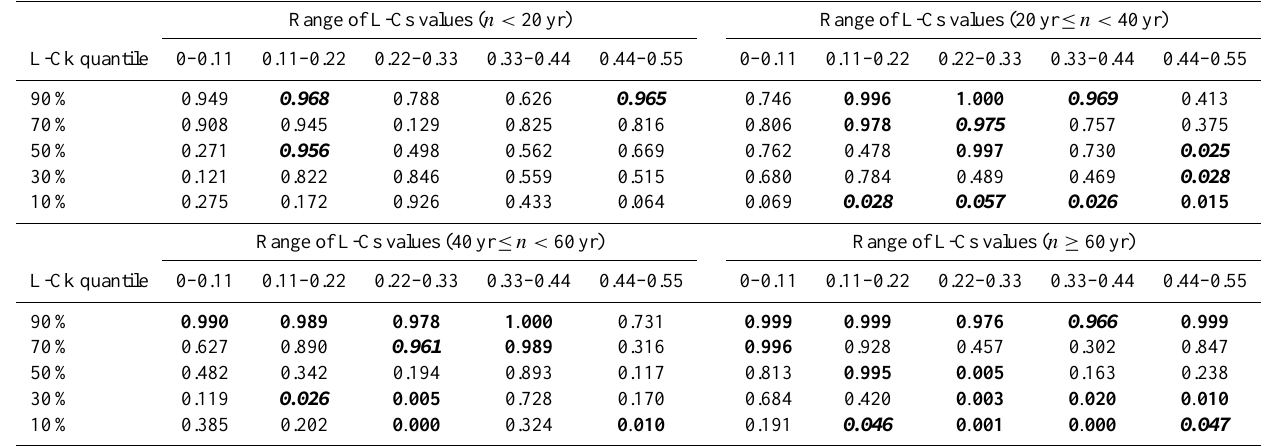
Table 2. Empirical p values for the observed quantiles of L-Ck given the sample distributions generated from the GEV simulations shown in Fig. 3. In bold, values rejecting a 5% significance test. In bold and italic, values rejecting a 10% significance